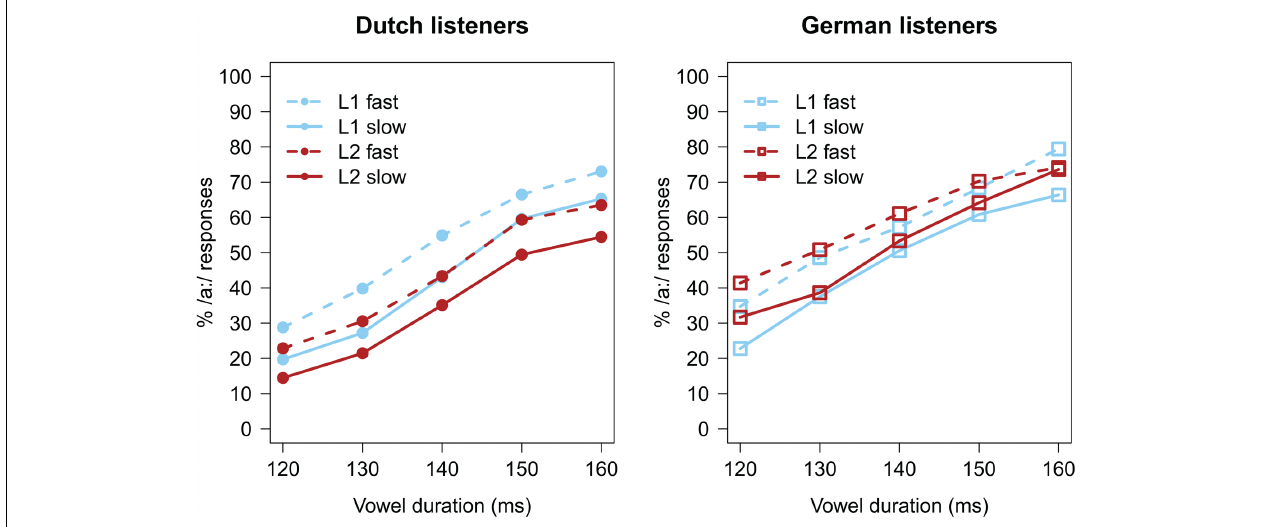
FIGURE 3 | Average categorization data (in % /a:/ responses) of Experiment 2. (Left) Data from the Dutch listener group; (Right) data from the German listener group.